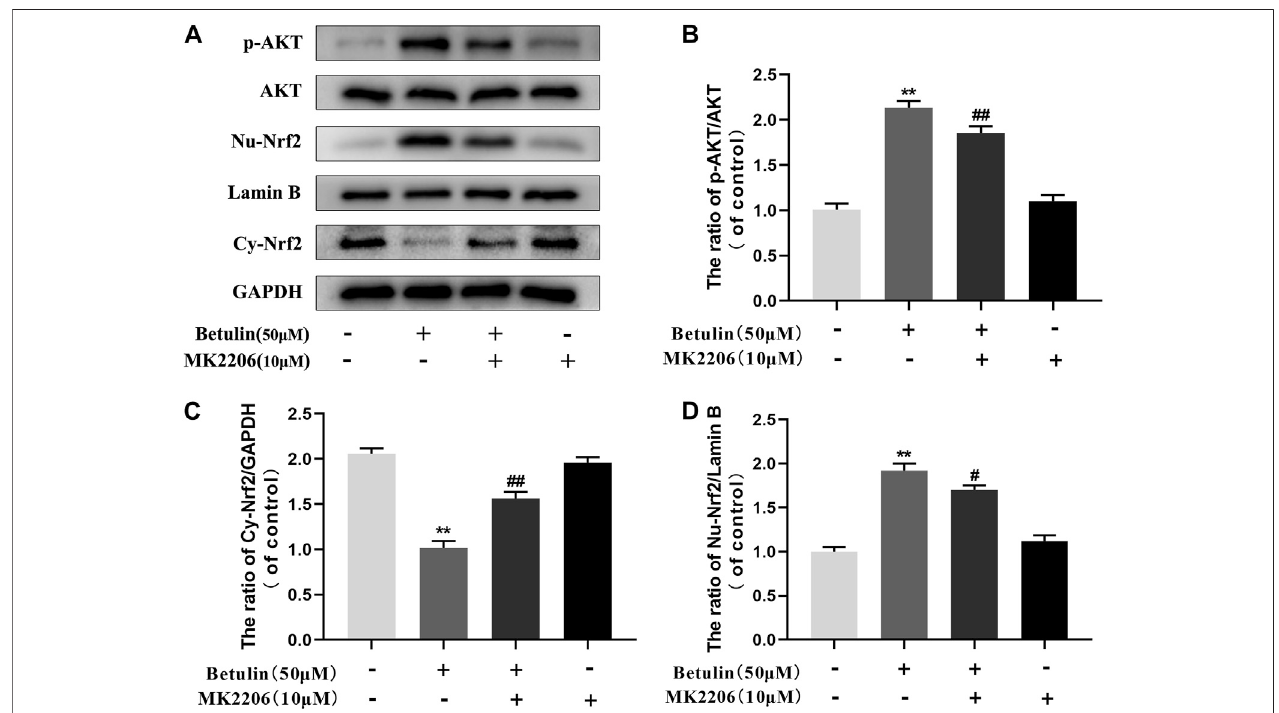
FIGURE 6 | Betulin promotes nuclear translocation of Nrf2 via the AKT signal pathway. The chondrocytes were pretreated with AKT inhibitor MK2206 (10 μ M) for 2 handthentreatedwithbetulin(50 μ M)for2 h. (A – D) TheproteinlevelsofNu-Nrf2,Cy-Nrf2,andp-AKTweredetectedbyWesternblottingandquantitativelyanalyzed. The results showed that the AKT signal participated in the in fl ammatory process induced by IL-1 β . The data in the fi gure show that the average value is ± SD, ** p < 0.01 compared with the control group, ## p < 0.01 compared with the Betulin-treated group, n (cid:2) 3.